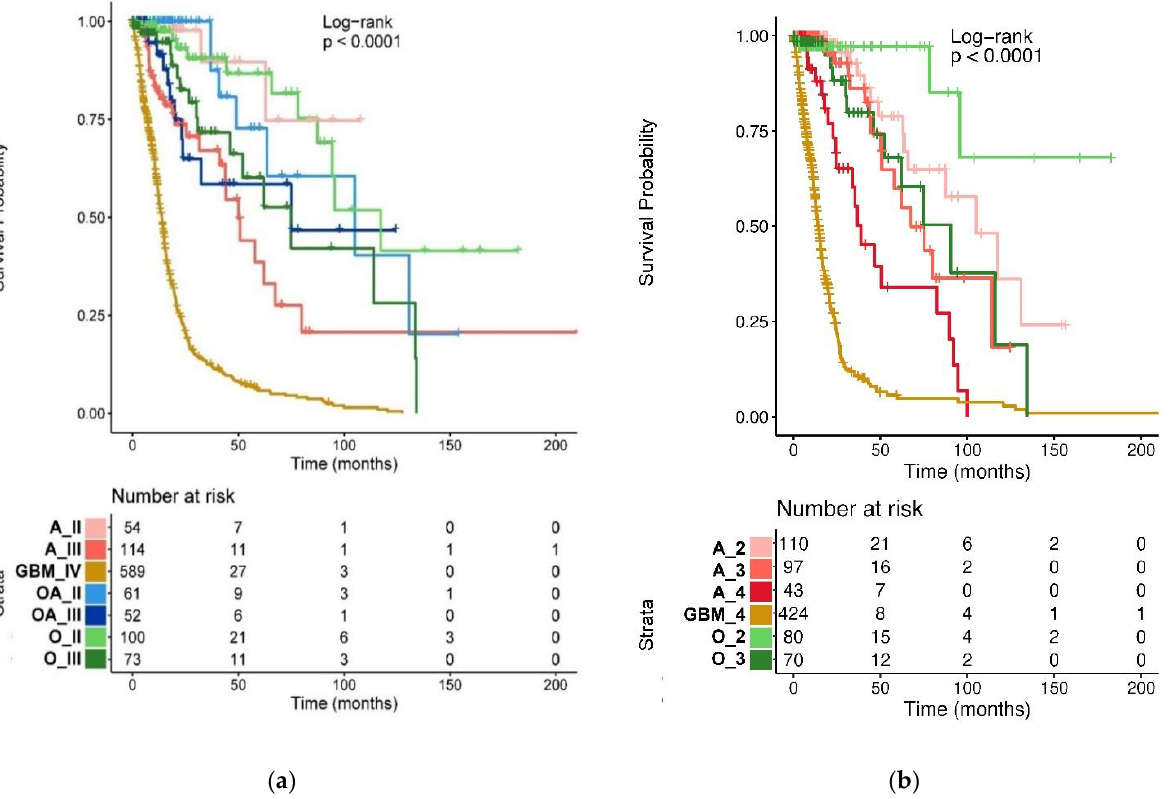
Figure 7. Kaplan – Meier analysis of 1043 TCGA patients with gliomas. Patient groups are shown Figure 7. Kaplan–Meier analysis of 1043 TCGA patients with gliomas. Patient groups are shown according to the basic TCGA ( a ) and the WHO CNS5 ( b ) classifications. A_II-III — astrocytoma, according to the basic TCGA ( a ) and the WHO CNS5 ( b ) classifications.